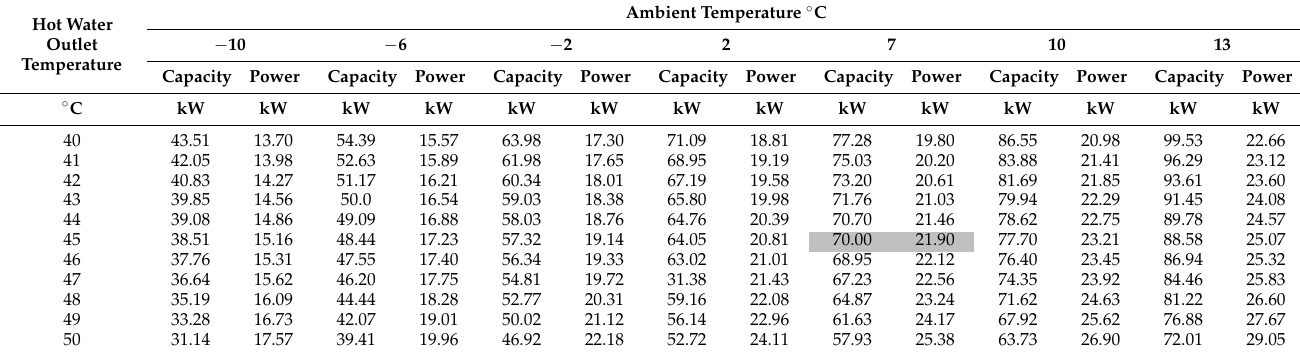
Table A2. Manufacturer’s data sheet of the studied